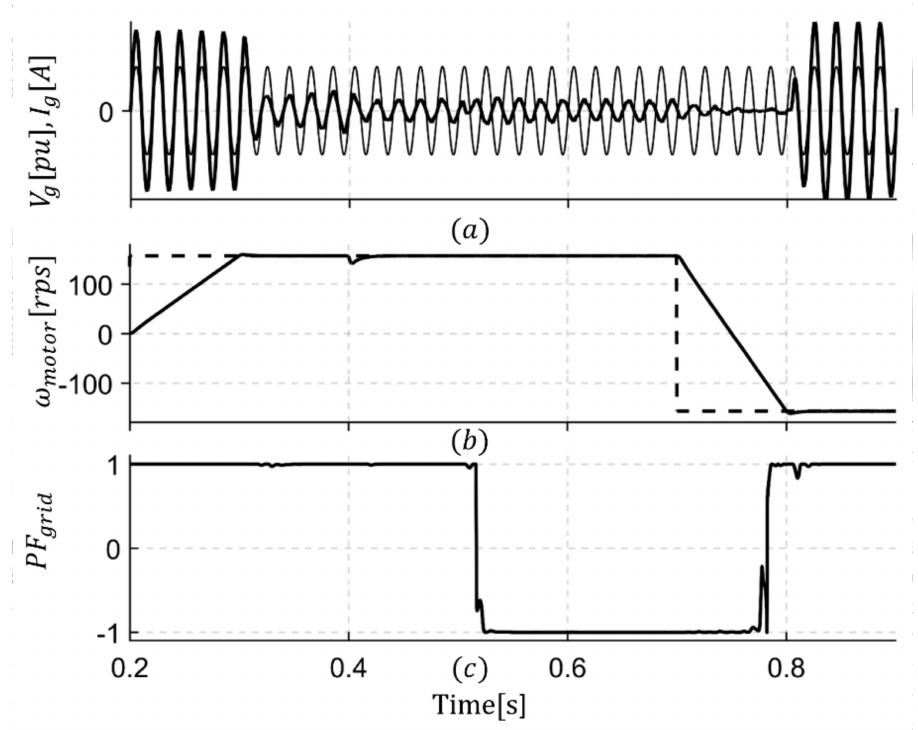
Figure 10. Response of the ( a ) grid current and normalized grid phase voltage, ( b ) PMSM speed, and ( c ) grid power